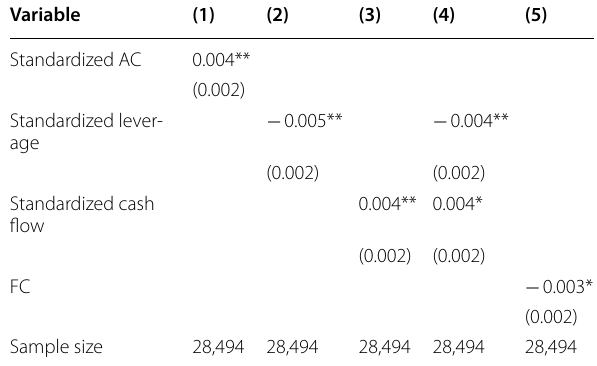
Table 3 The effect of alternative indicators of